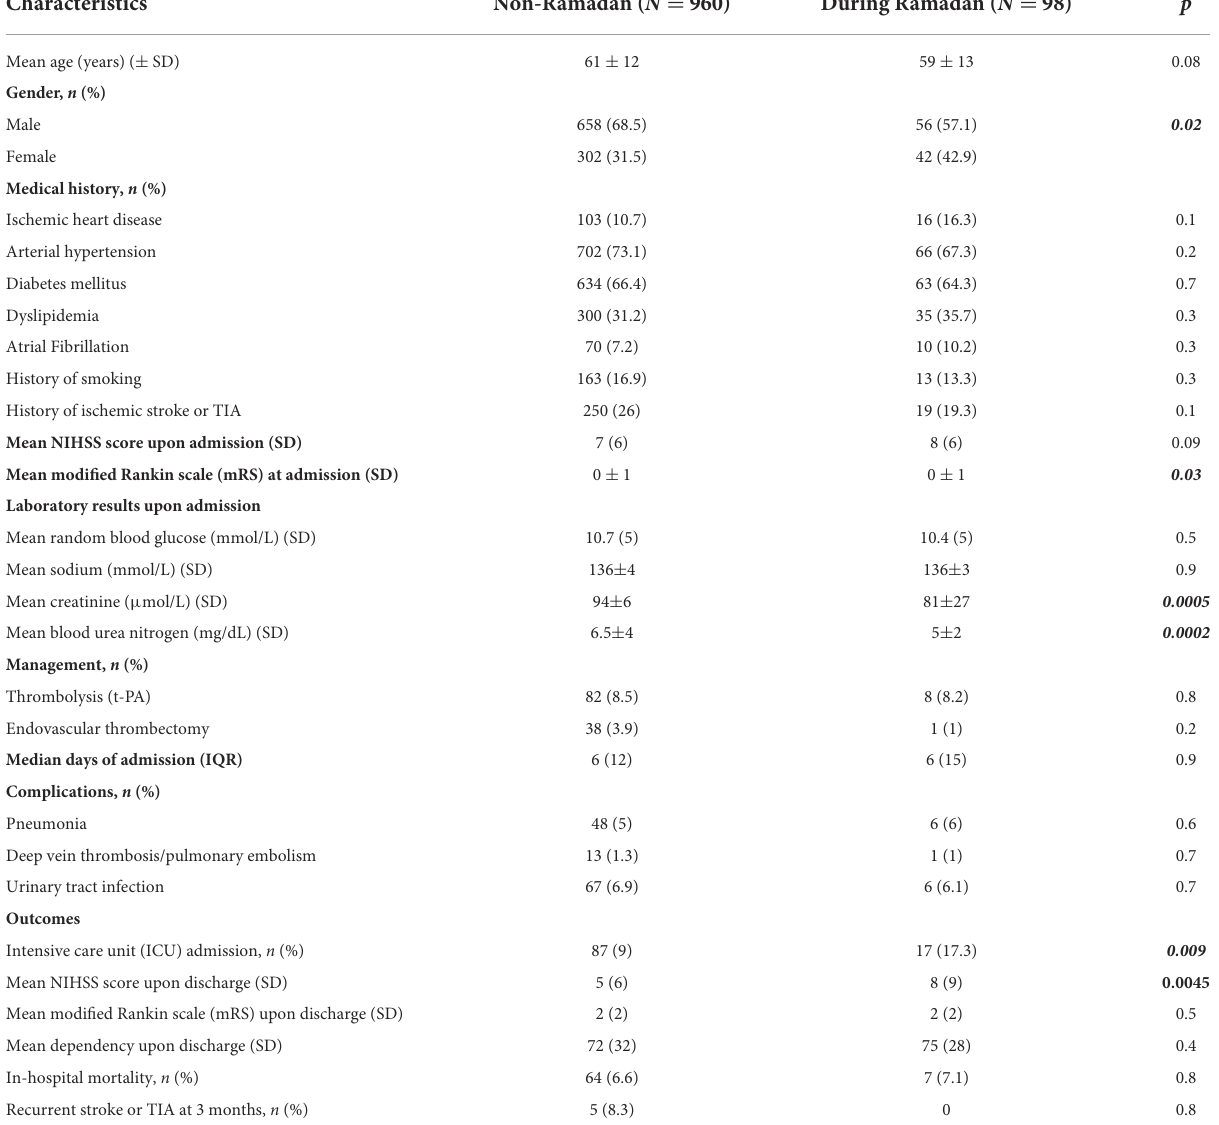
TABLE 2 Clinical characteristics of ischemic stroke (IS) patients in Ramadan months vs. non-Ramadan months. Characteristics Non-Ramadan ( N =